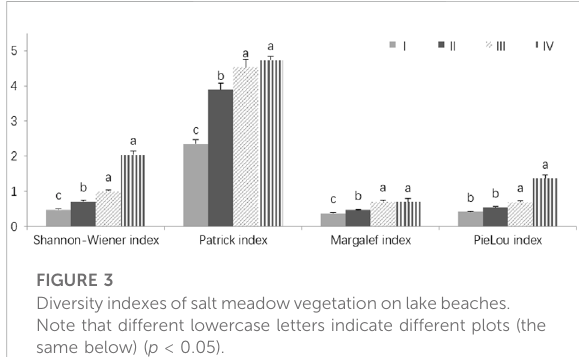
FIGURE 3 Diversity indexesof salt meadowvegetation on lakebeaches. Note that different lowercase letters indicate different plots (the same below) ( p <